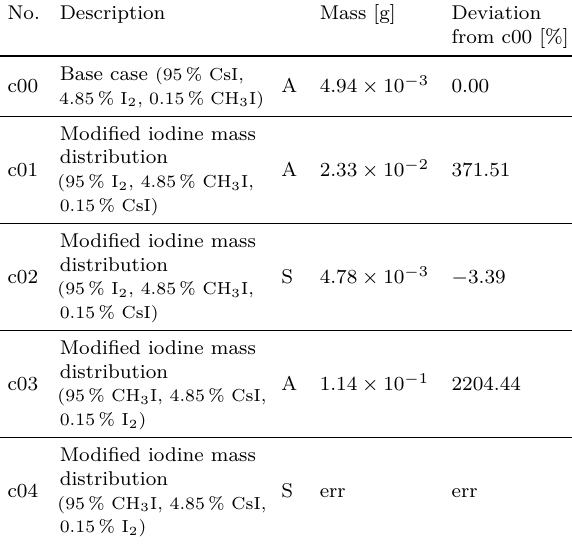
Table 4. Overview on calculation and